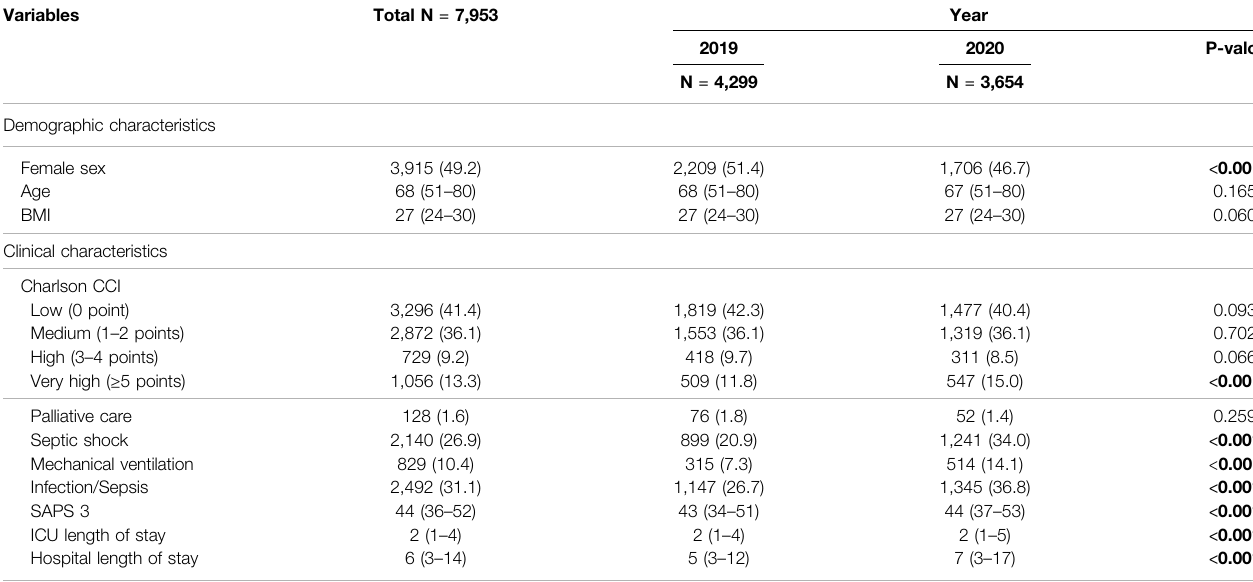
TABLE 1 | Characterization of the study population (Rio de Janeiro,